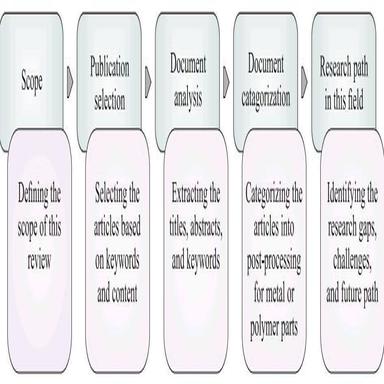
Details of methodology used in the present review.